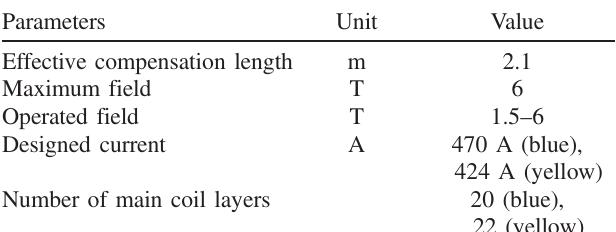
Yellow: Horizontal Yellow: Vertical